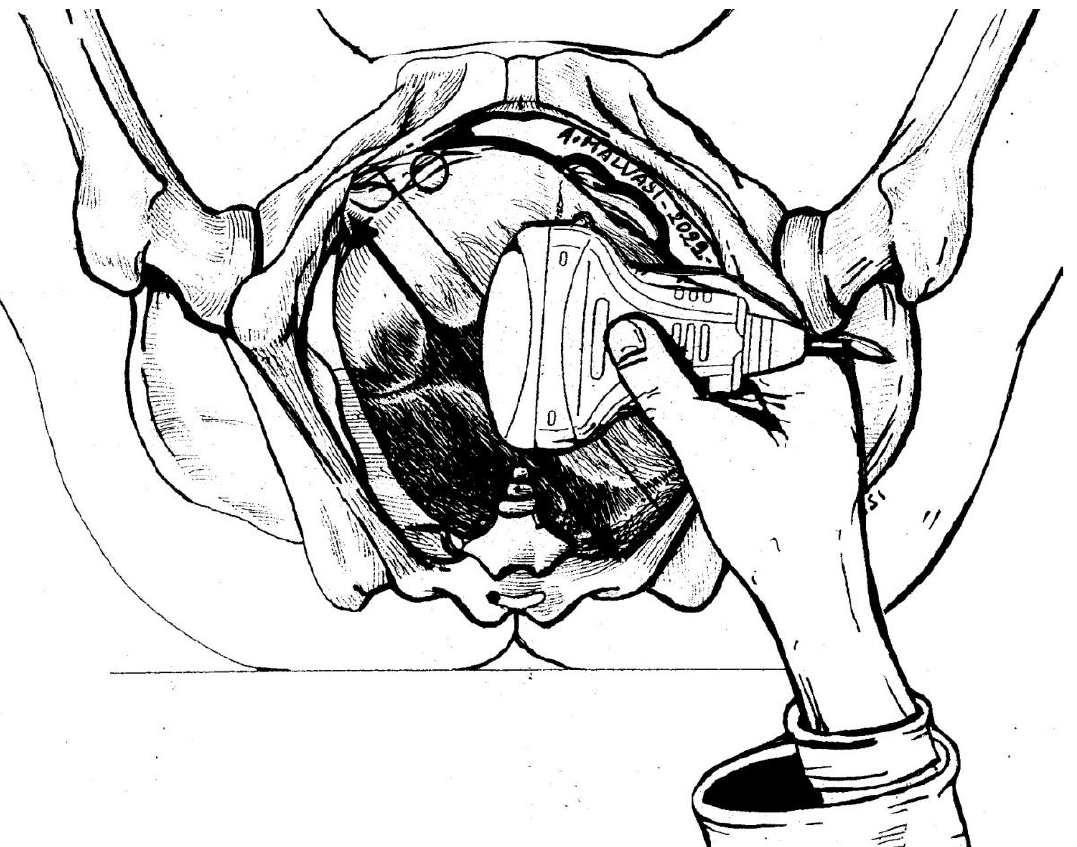
Figure 5. The translabial sonography technique was introduced in the labor ward later than transabdominal intrapartum ultrasound. The operator must place the linear probe between the labia majora of the parturient in different orientations according to the several signs considered. In this picture, the probe is at the sagittal plane of the pelvis, which is a landmark to compare the fetal head midline orientation in order to discriminate the fetal head attitude. In this picture, the occiput position is posterior left plus anterior asynclitism. Using a 3D linear probe, it is possible to obtain from this scan further planes of reconstruction to better assess or confirm fetal head malposition or malpresentation.